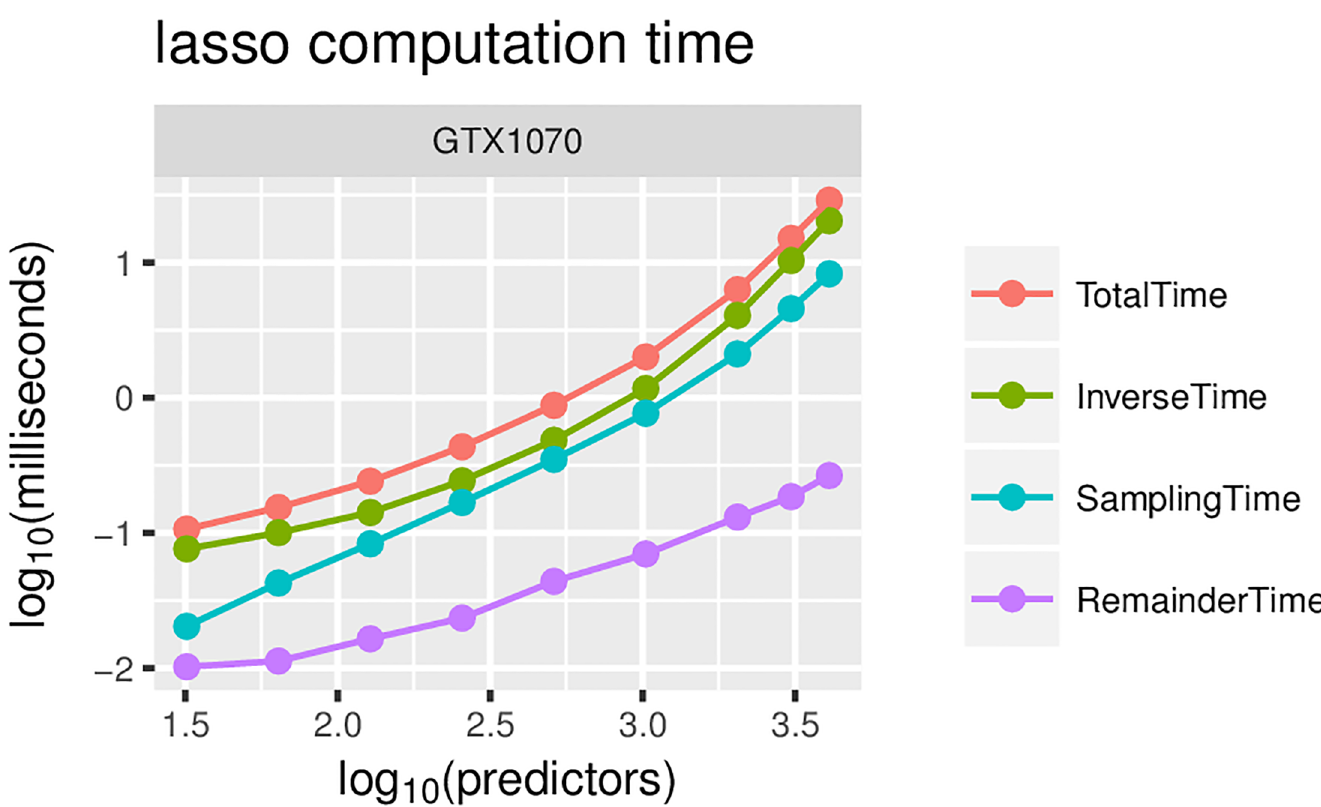
Fig 5. Lasso computation times for GTX1070, broken down by key algorithm components. The results for other GPUs are very similar, and thus, we omit them.